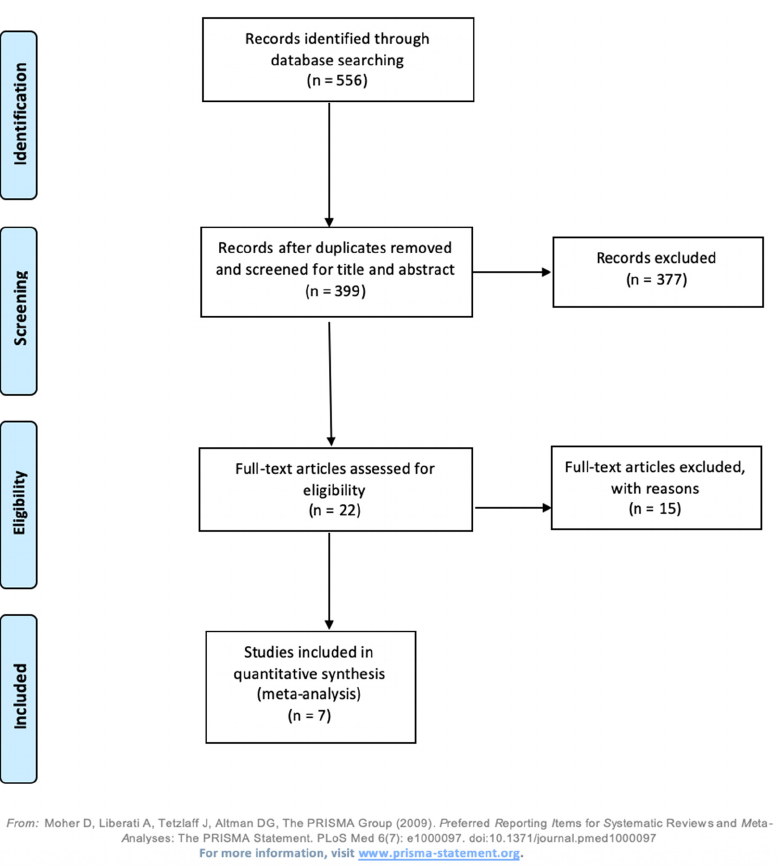
Figure 1. Prisma flow chart of the study selection process for this systematic review.